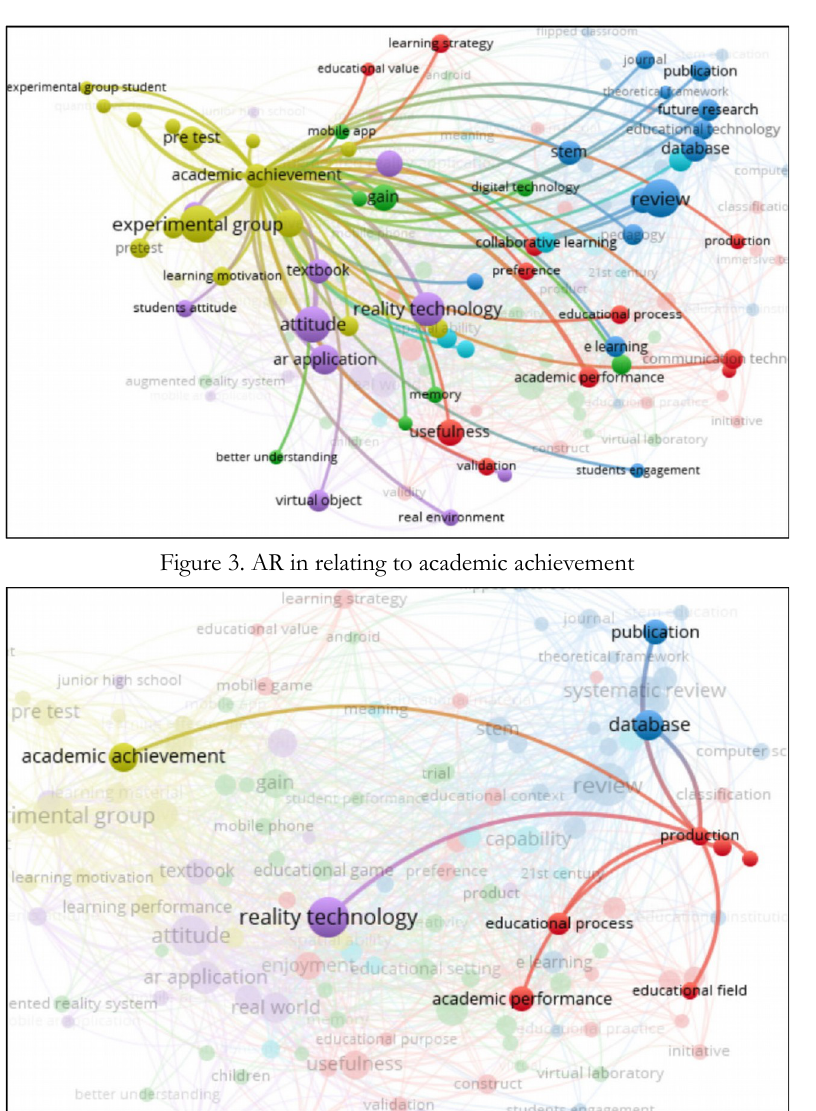
Figure 4. AR in relating to production